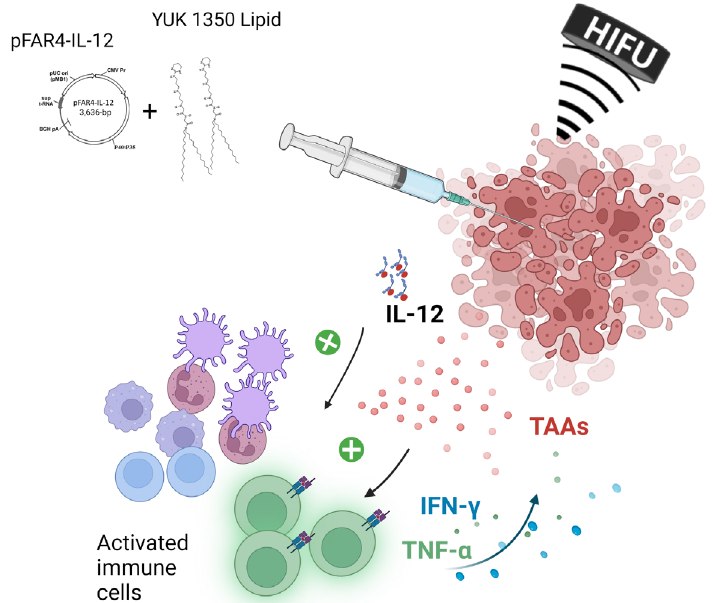
Figure 4. Scheme of in vivo combined treatment strategy investigated in this paper. TAAs: tumor associated antigens Combined in vivo